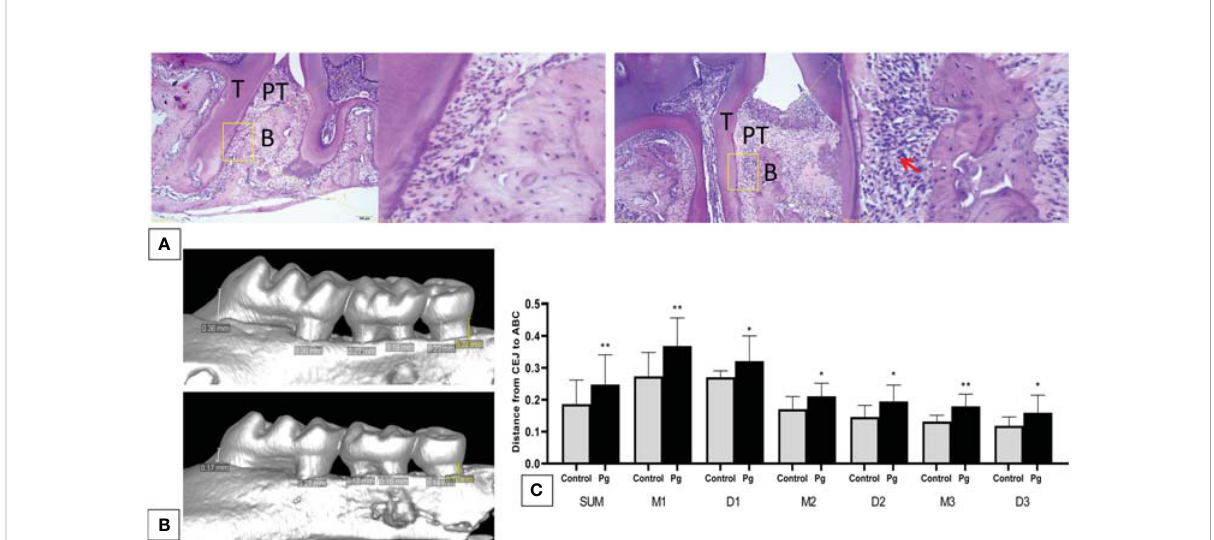
FIGURE 2 Oral administration of Porphyromonas gingivalis for 22 weeks induced periodontitis. (A) Histological examination of the hemi-maxillae ( T , tooth; PT , periodontal tissue; B , alveolar bone) stained with hematoxylin – eosin (H&E). Apparent losses of periodontal attachment and alveolar bone resorption. The arrow shows in fl ammatory cells that have in fi ltrated the periodontal tissue. (B) Buccal side maxillary alveolar bone loss measured from the cemento-enamel junction (CEJ) to the alveolar bone crest (ABC) at six points — 1 ) mesiobuccal and 2 ) distobuccal regions for the fi rst maxillary molar; 3 ) mesiobuccal and 4 ) distobuccal regions for the second maxillary molar; and 5 ) mesiobuccal and 6 ) distobuccal regions for the third maxillary molar — in mice from the P. gingivalis- administered group and the control group. (C) comparison of the six CEJ – ABC linear distances ( SUM , the sum of six points; M1 , mesiobuccal for the fi rst maxillary molar; D1 , distobuccal for the fi rst maxillary molar; M2 , mesiobuccal for the second maxillary molar; D2 , distobuccal for the second maxillary molar; M3 , mesiobuccal for the third maxillary molar; D3 , distobuccal for the third maxillary molar). * p < 0.05, ** p < 0.01. N = 6. Data are expressed as the mean ±